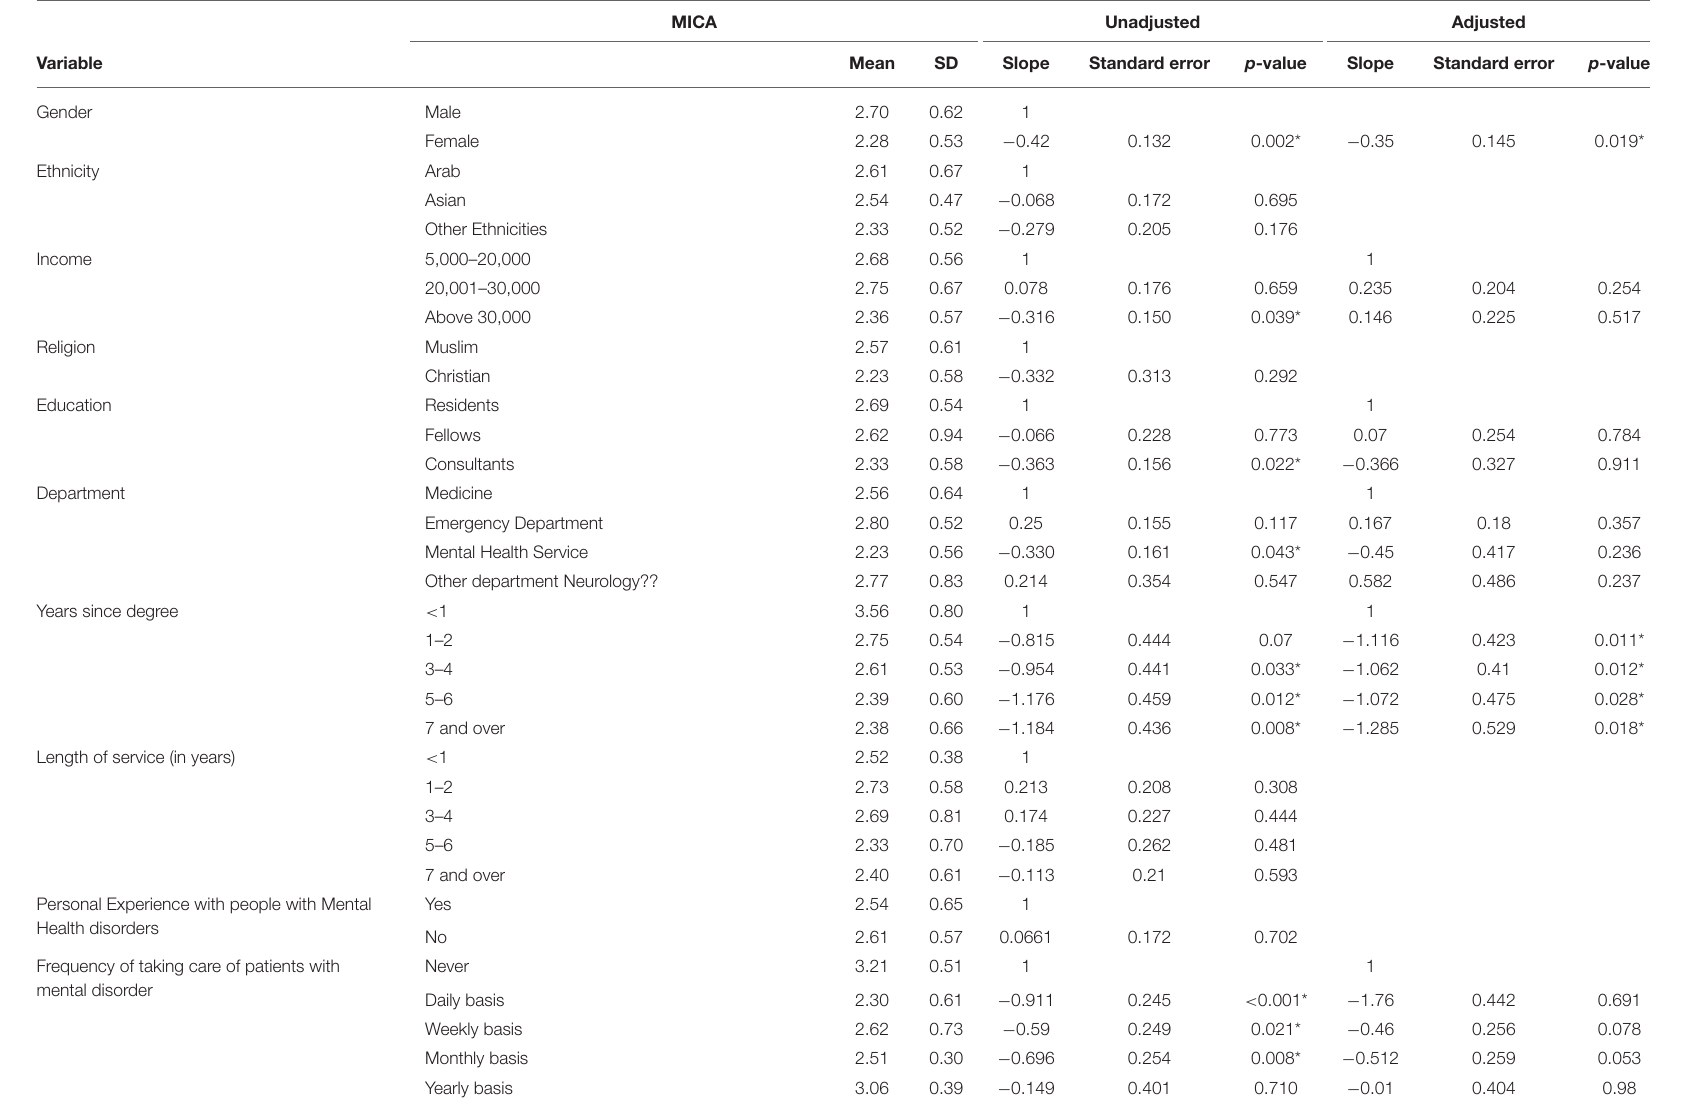
TABLE 4 | Association between MICA scores and physicians’